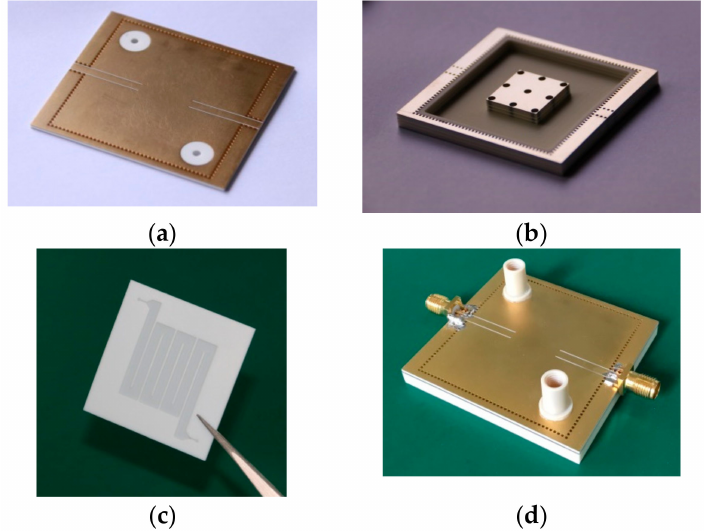
Figure 11. Photographs of the fabricated sensor: ( a ) the top layer; ( b ) the bottom layer of the cavity; ( c ) the microfluidic layer and ( d ) the assembled